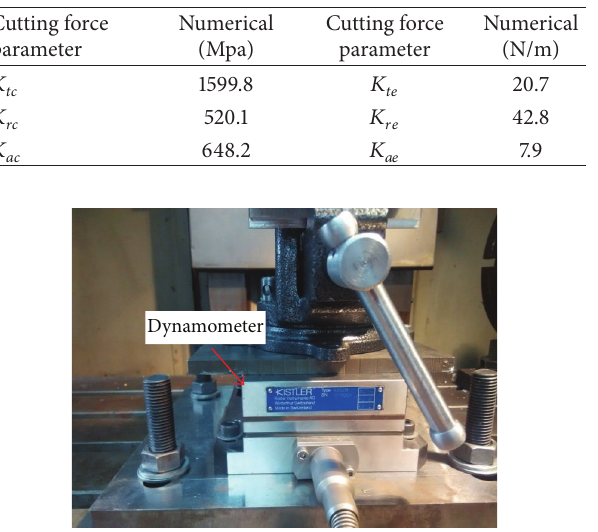
Table 3: Cutting force coefficient.